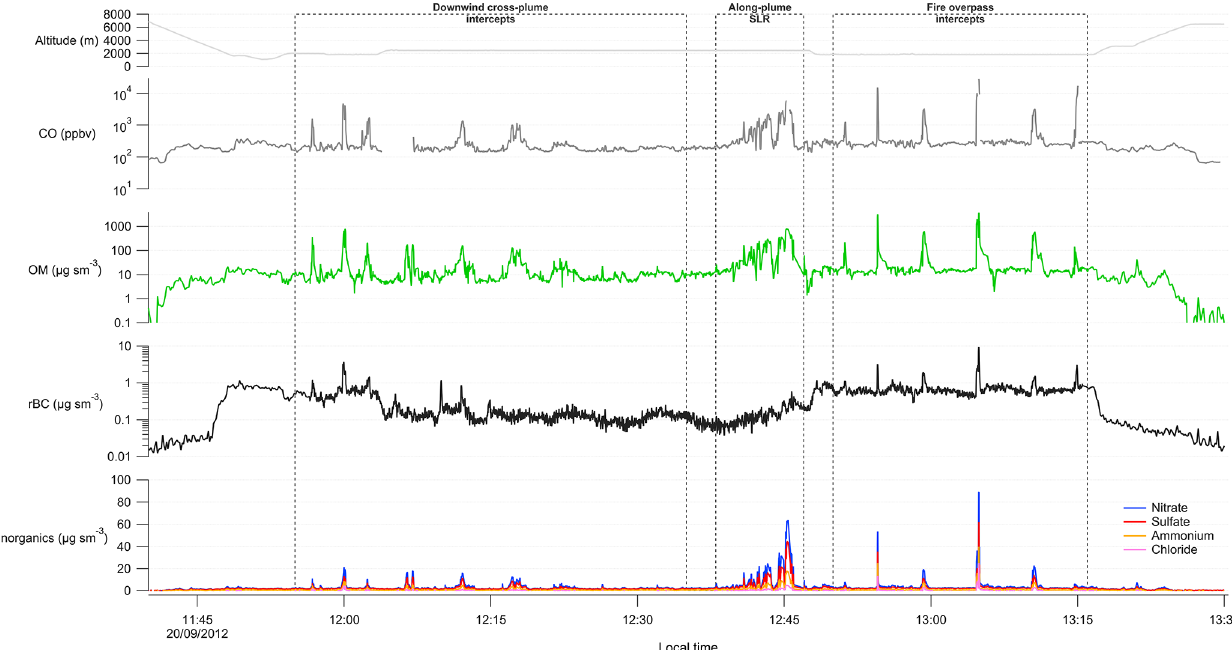
Figure 2. Time series of altitude, carbon monoxide (CO), organic matter (OM), refractory black carbon (rBC) and inorganic aerosol compo- nents during the case study analysis for flight B737. Downwind cross-plume intercepts, the along-plume straight-and-level run (SLR), and fire overpass intercepts across the plume are indicated by the dashed boxes. The fire itself was located on a 900m high